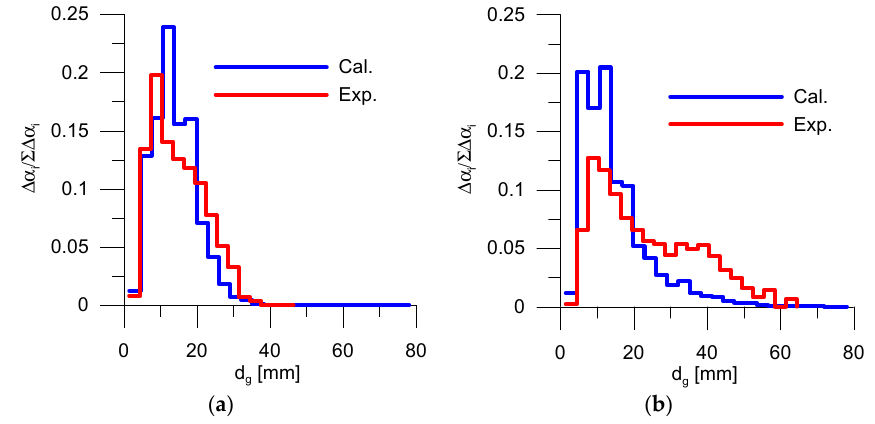
Figure 14. Evolution of normalized bubble size distribution at the wire-mesh sensor (WMS) plane (Case 1): ( a ) t = 39 s; ( b ) t = 45 s.